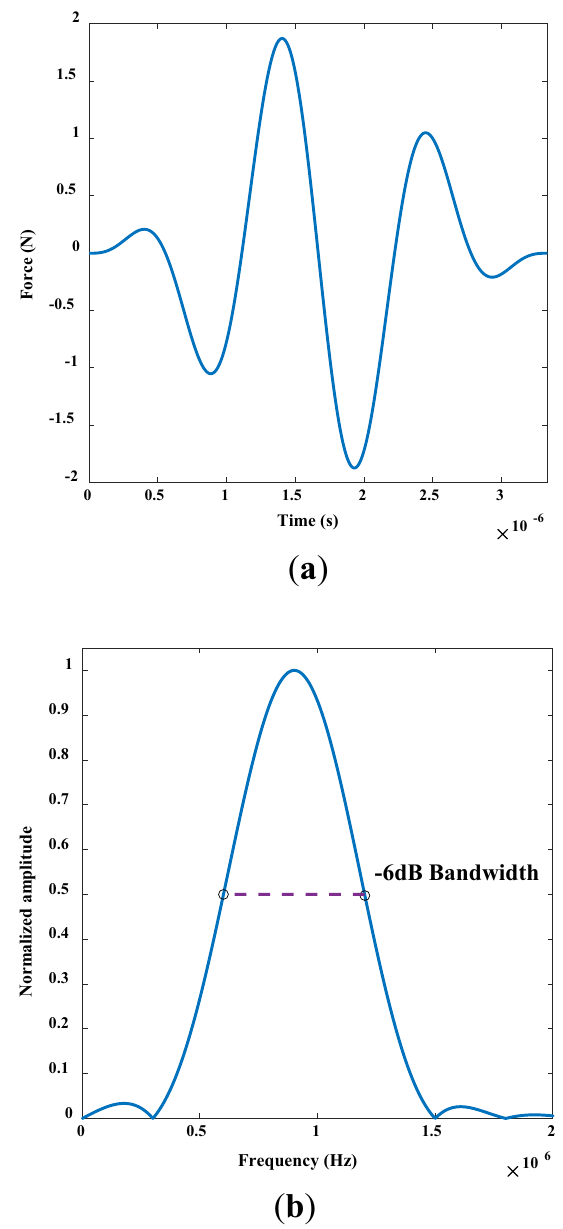
Figure 8 (a) Excitation signal of the windowed sinusoid of three cycles, ( b) frequency spectrum of the excitation